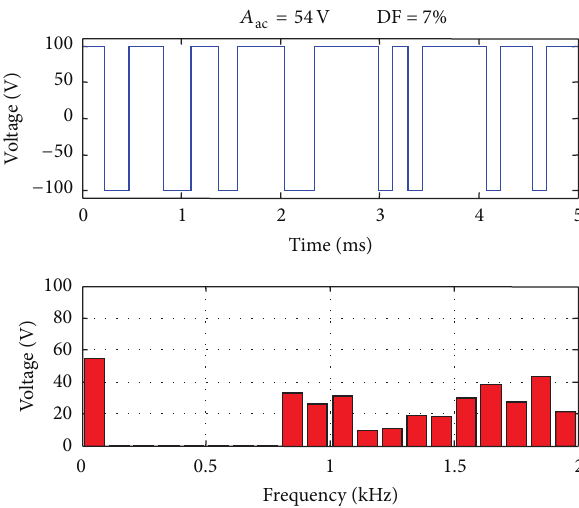
Figure 7: Optimal conventional design with 𝑀 = 8 switching cycles. PWM signaland harmonicdistributionfortheACamplitude = 100 V. = 54 V with a fundamental frequency of 50Hz and 𝑉 𝐴 dc ac